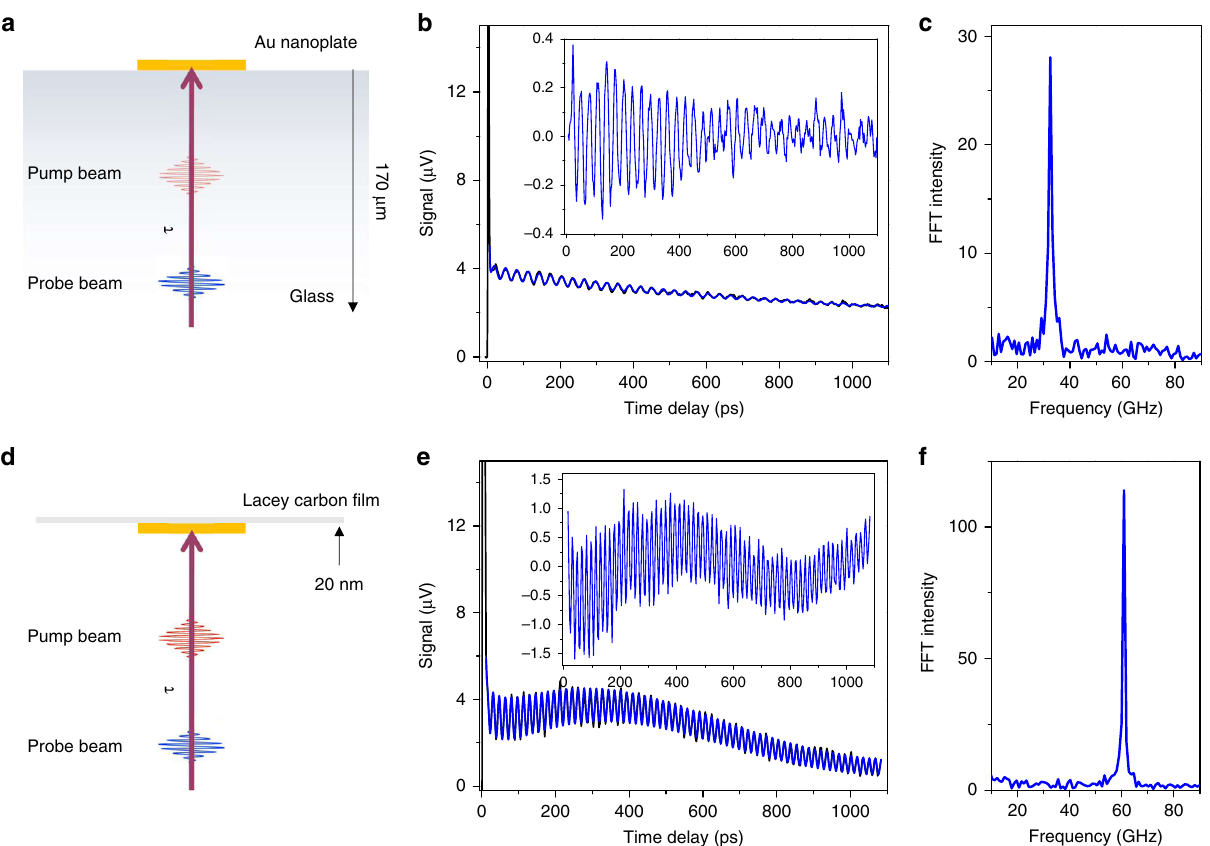
Fig. 1 Brillouin oscillations and localized acoustic vibrations of Au nanoplates. a Diagram of experimental geometry for Brillouin oscillation detection where the Au nanoplates were deposited on glass substrate. b Transient absorption trace of a Au nanoplate where Brillouin oscillations are observed. The blue line is the fi tting curve to the experimental data with one oscillation term, see Eq. (1). The inset shows the isolated Brillouin oscillation component. c Fast Fourier transform (FFT) of the Brillouin oscillations. d Diagram of experimental geometry for localized acoustic vibration detection where the Au nanoplates were deposited on Lacey carbon fi lm. e Transient absorption trace of acoustic vibrations. The blue line is the fi tting curve to the experimental data with two oscillation terms. The inset shows the isolated acoustic vibrations. f FFT of the acoustic vibrations. The glass substrate and Lacey carbon fi lm have thickness of 170 μ m and 20 nm,